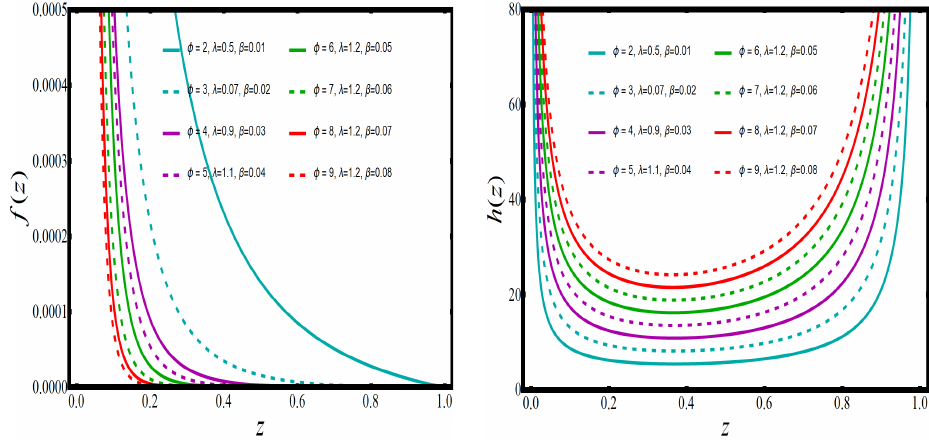
Figure 3. Variations of PDF and HRF of the HLUG-TI at different values of Fig. 3. Variations of PDF and HRF of the HLUG-TI at di⁄erent values of parameters.